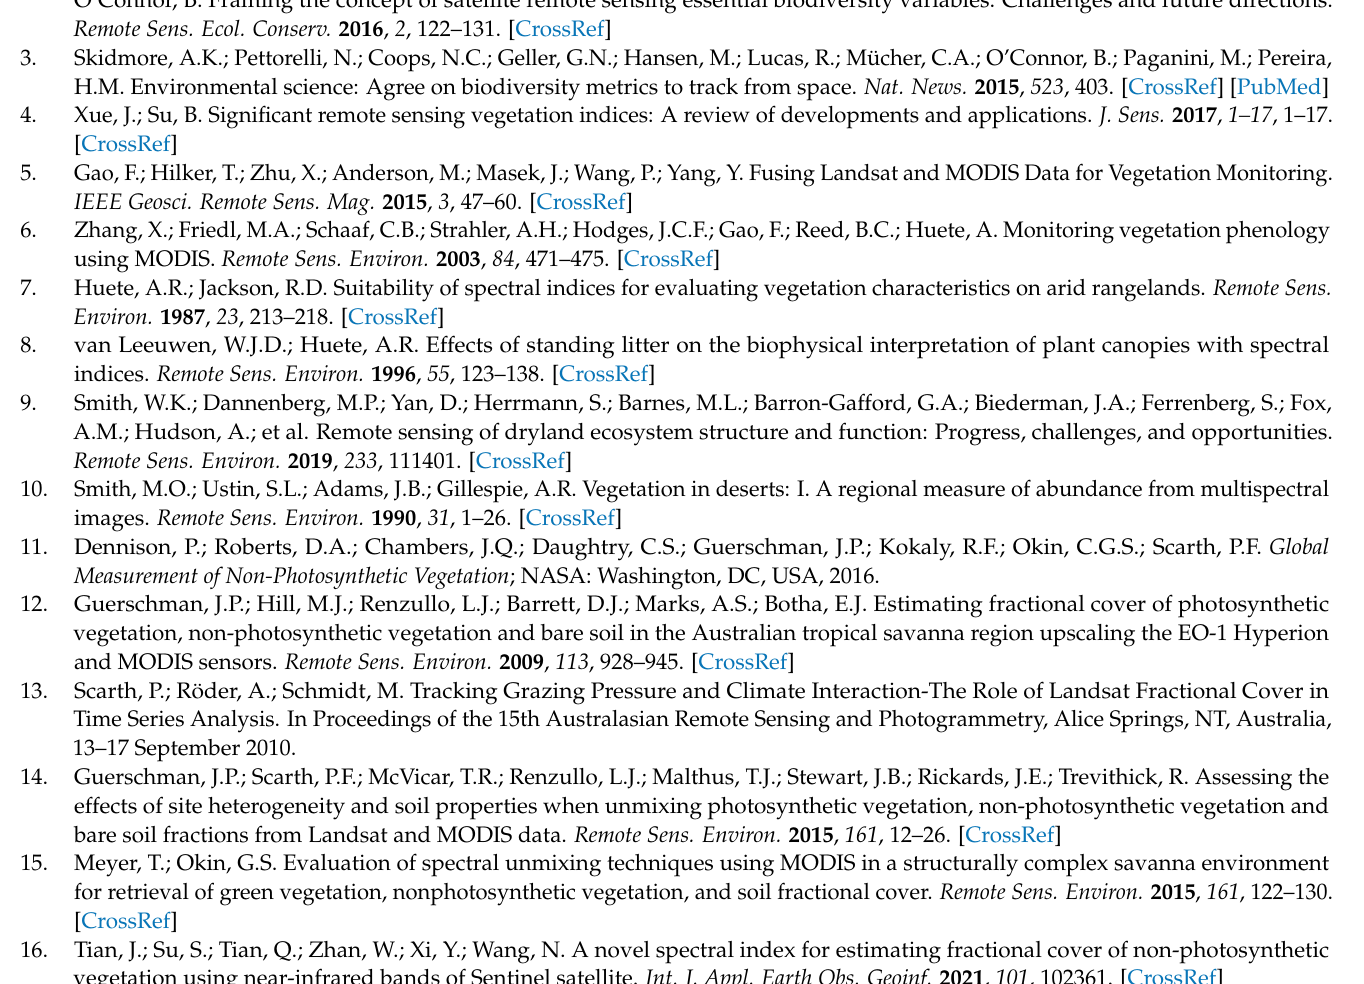
Figure A3. Scatter plots of field-measured ( a ) photosynthetic vegetation and ( b ) bare soil fractions (%) against unmixing error (%). The dashed line represents the linear fit between the variables. Intercept and slope were significant with p < 0.0000001 in both cases ( n = 4207) .